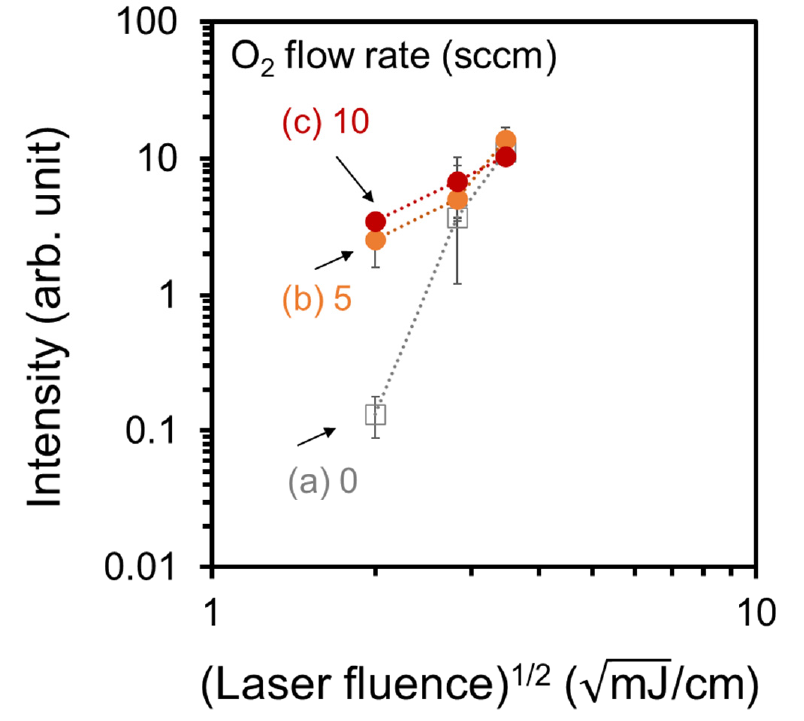
Figure 10. Ion intensity for N-BP-Cl on the high-quality CNWs ionization-assisting substrates as a function of the laser fluence: ( a ) normal CNWs, ( b ) 5-sccm-O 2 –, and ( c ) 10-sccm-O 2 – high-quality CNWs.